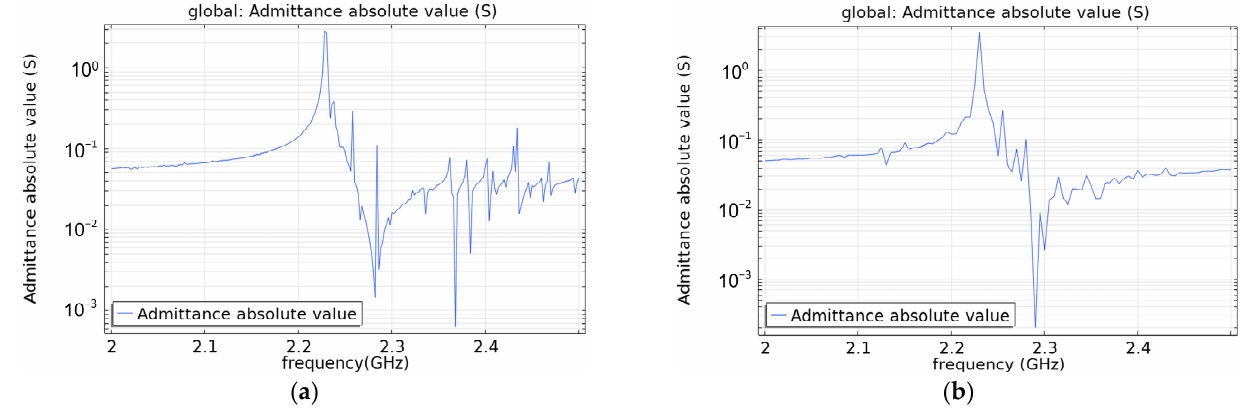
Figure 10. Absolute values of admittance for different electrode shapes: ( a ) square electrode and ( b ) pentagonal electrode.